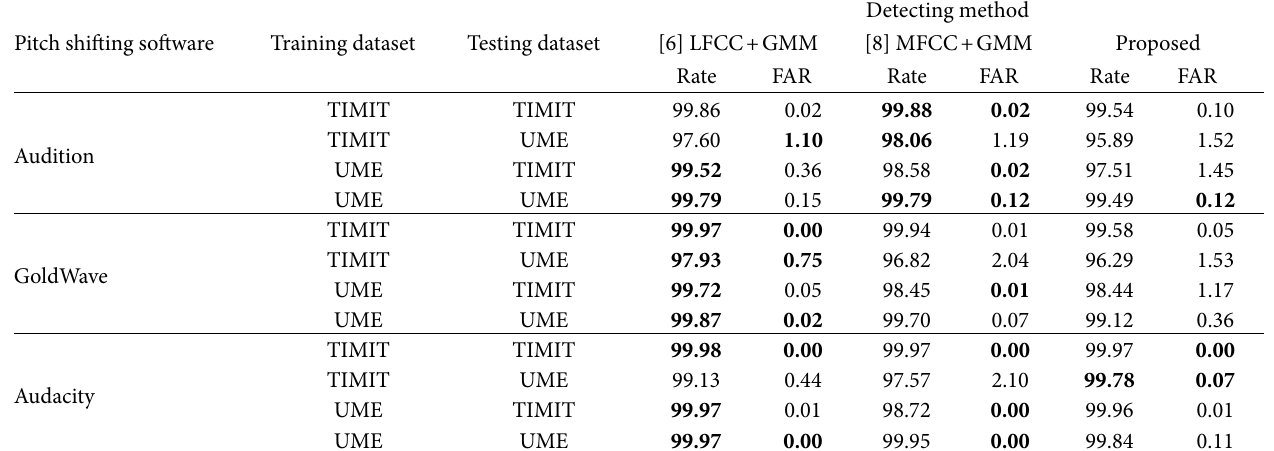
Table 2: Detection performance of strongly pitch-shifted voice in binary classification.